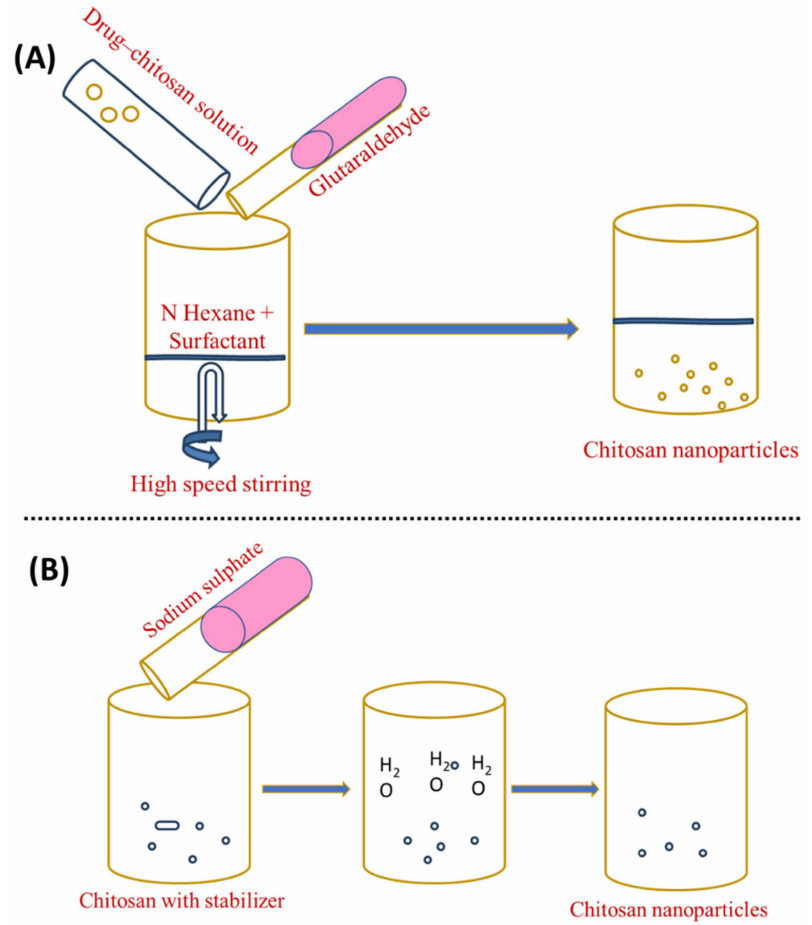
Figure 4. Preparation of chitosan nanoparticles by ( A ) reverse micellisation and ( B )